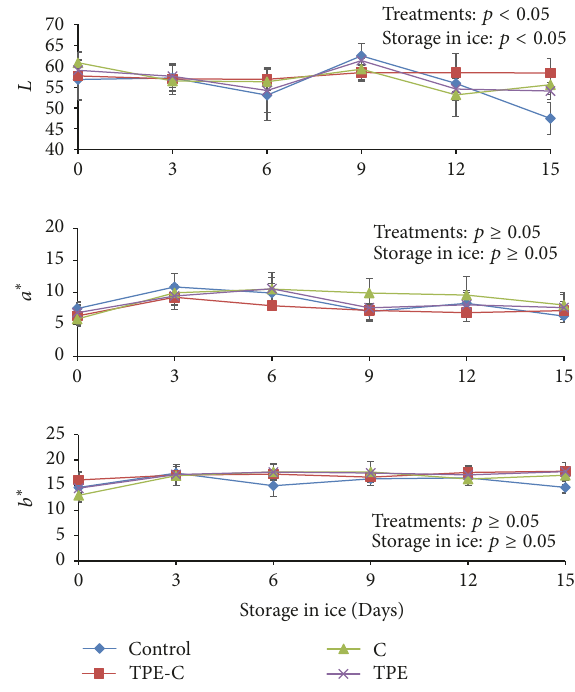
Figure 3: Changes in the parameters of color ( 𝐿 , 𝑎 ∗ , and 𝑏 ∗ ) in fillets of sierra (Scomberomorus sierra) with different treatments: (a) control, (b) tomato plan extract, (c) chitosan, and (d) tomato plant extract-chitosan, stored during 15 days in ice. The values are the average of 𝑛 = 4 ± the standard deviation.